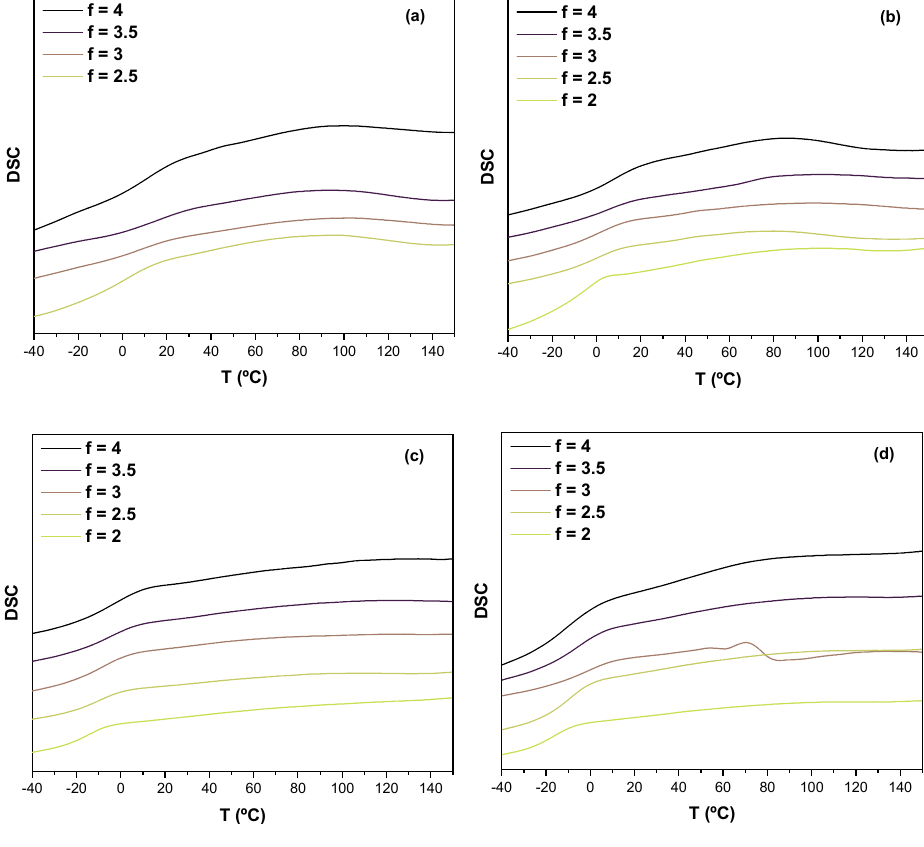
Figure 8. DSC analysis results. ( a ) EDA, ( b ) HMDA, ( c ) Pr–1075, ( d ) Pr–1075–DBA. The glass transition temperature is the most relevant data can be extracted from the analysis and the values obtained are represented in Figure 9.